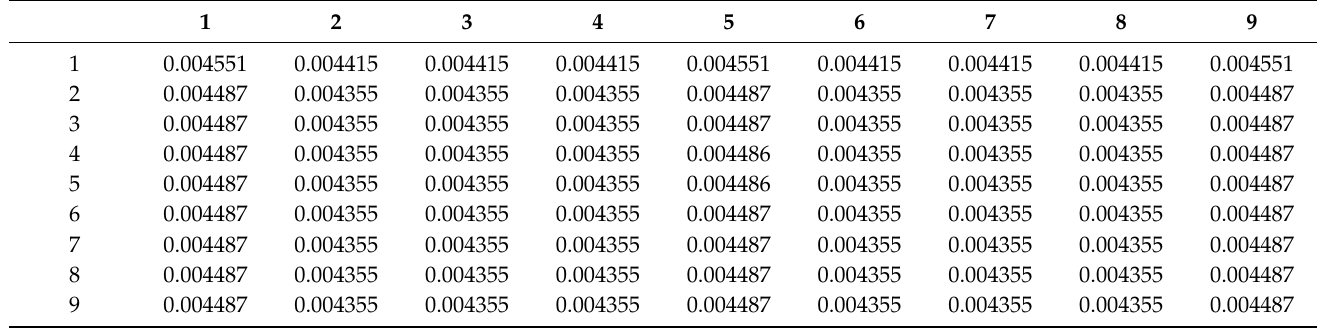
Figure 8. Schematic diagram of an example microlens array scanning imaging system (Y axis, δ = − 2 ◦ , θ = − 2 ◦ ). Table 3. Power value (Watts) of each aperture (Y axis, δ = − 2 ◦ , θ = − 0.5 ◦ ).